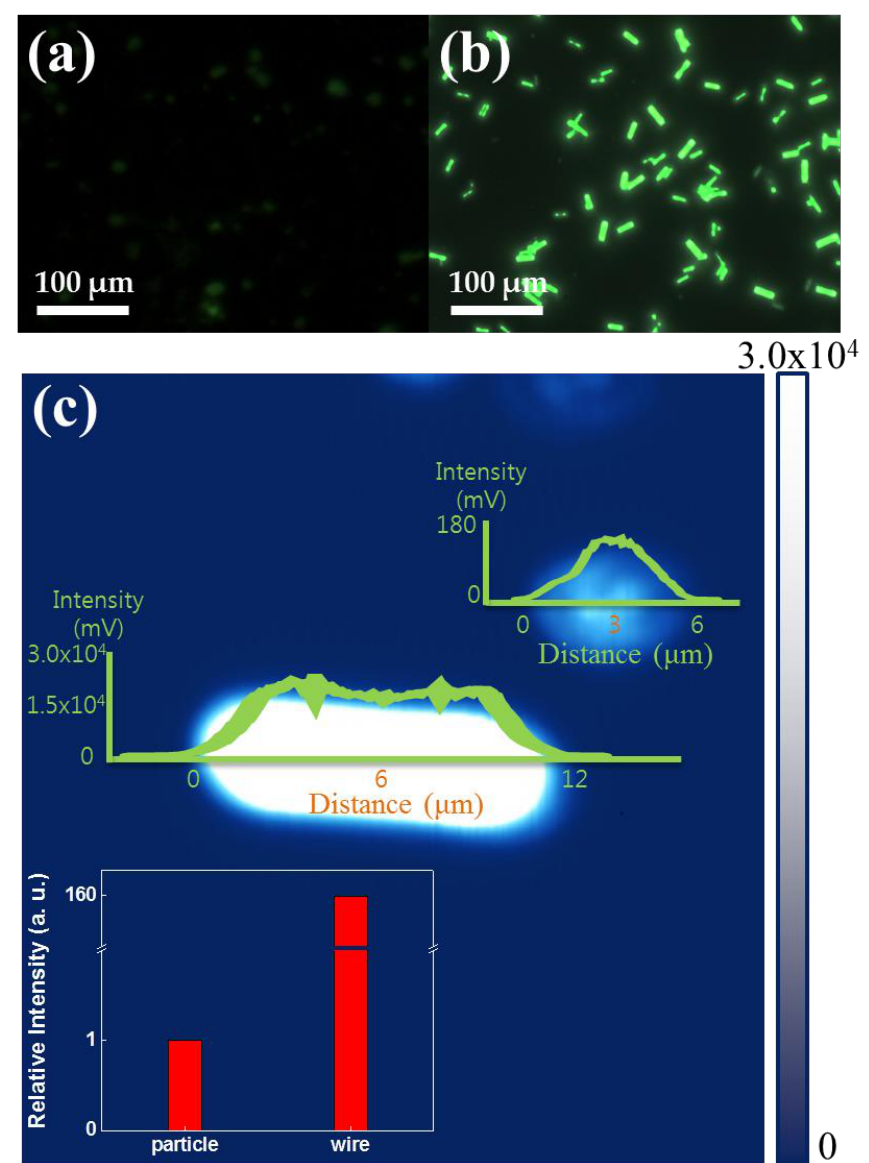
Figure 3. Color charge-couple device (CCD) images of ( a ) Alq 3 NPs and ( b ) crystal hexagonal column of Alq 3 MWs. ( c ) Photoluminescence image of both crystal Alq 3 MW and amorphous Alq 3 particle. (inset shows relative luminescence intensity of particle and wire).